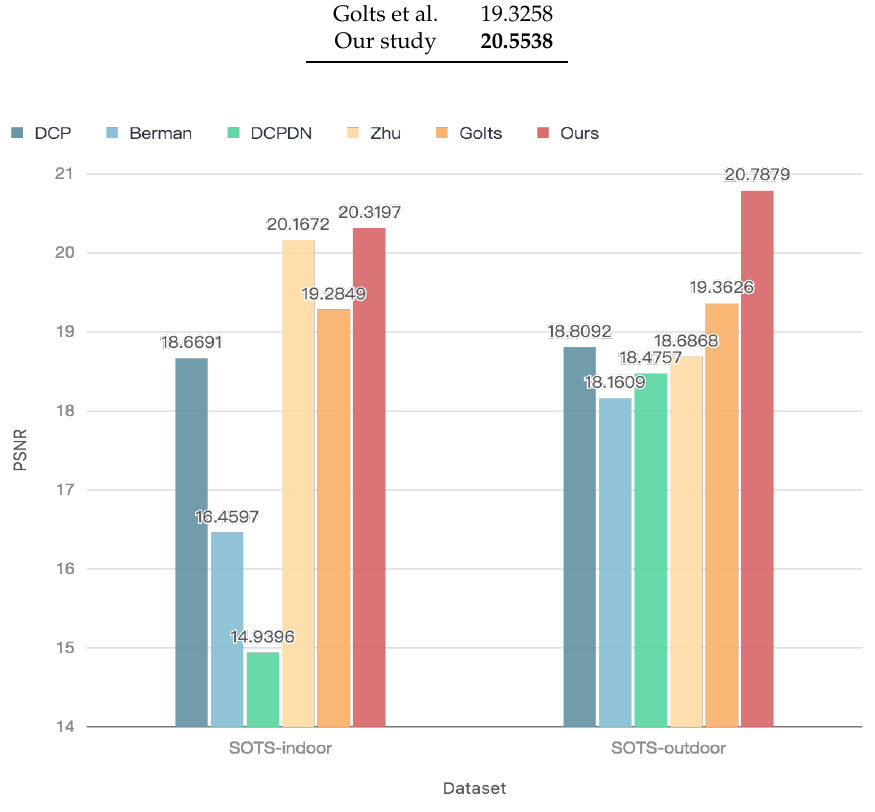
Figure 12. The quantitative results of dehazed images in the RESIDE test